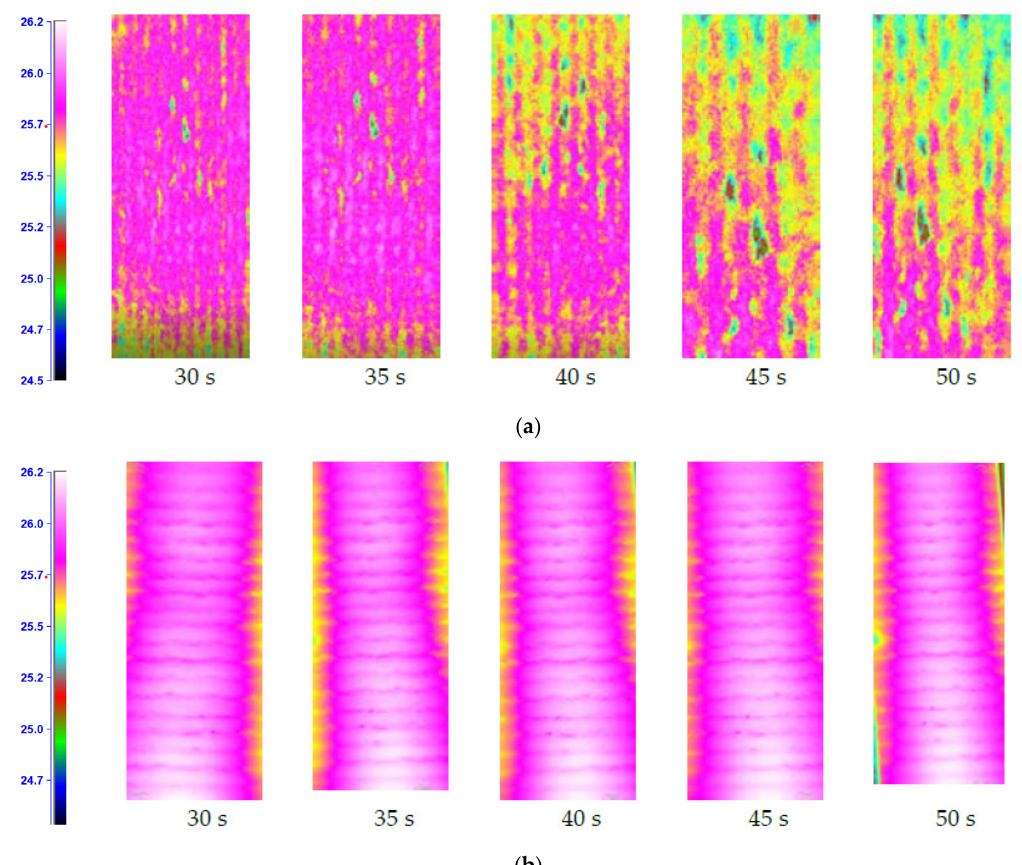
Figure 7. Temperature distribution maps for S4 ( a ) and S1 ( b ) structure composite. The analysis of thermograms showed that the process of heating and heat dissipation for carbon-reinforced composites is faster. Already after 45 s, significant changes in ther- mograms were observed. The S2 structure showed no temperature drop even after 50 s.